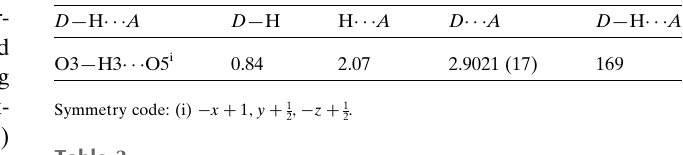
Table 3 Hydrogen-bond geometry (A˚ , (cid:4) ) for SY20C174 ( II